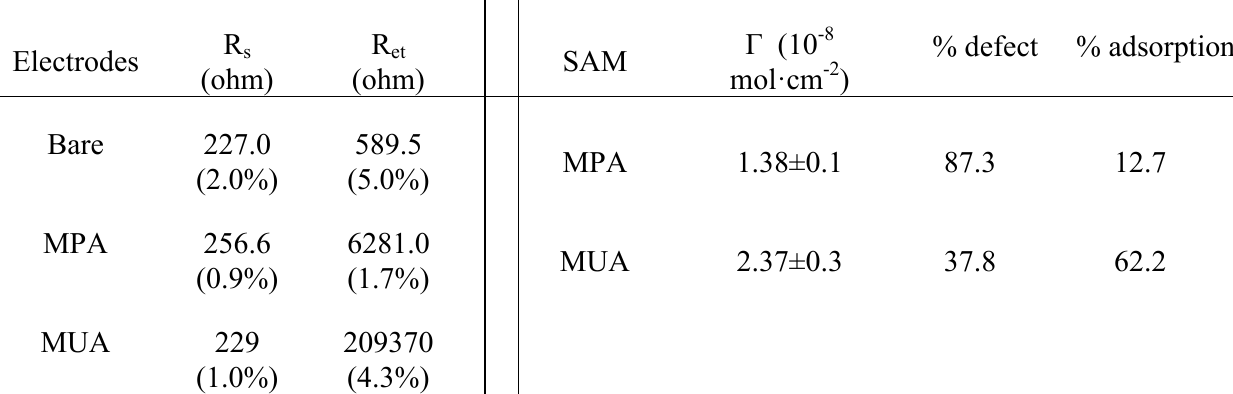
Table. 1. Left: the resolved R given in parenthesis). Right: the obtained values for the surface coverage and percent